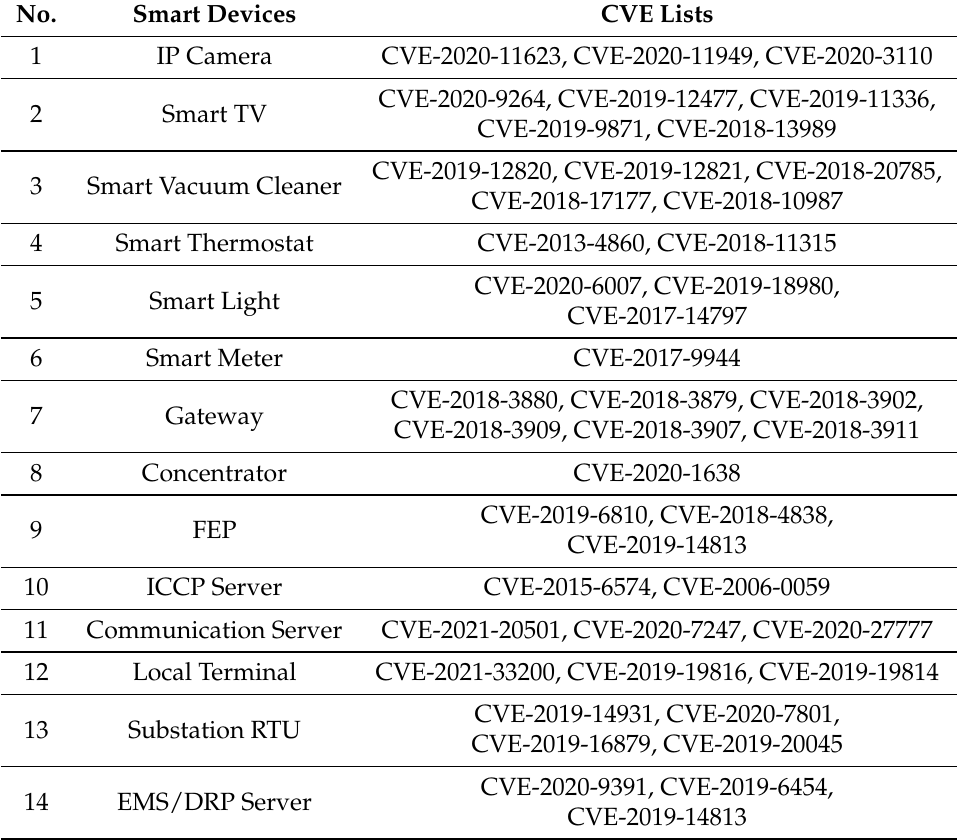
Table 3. CVE list for smart grid